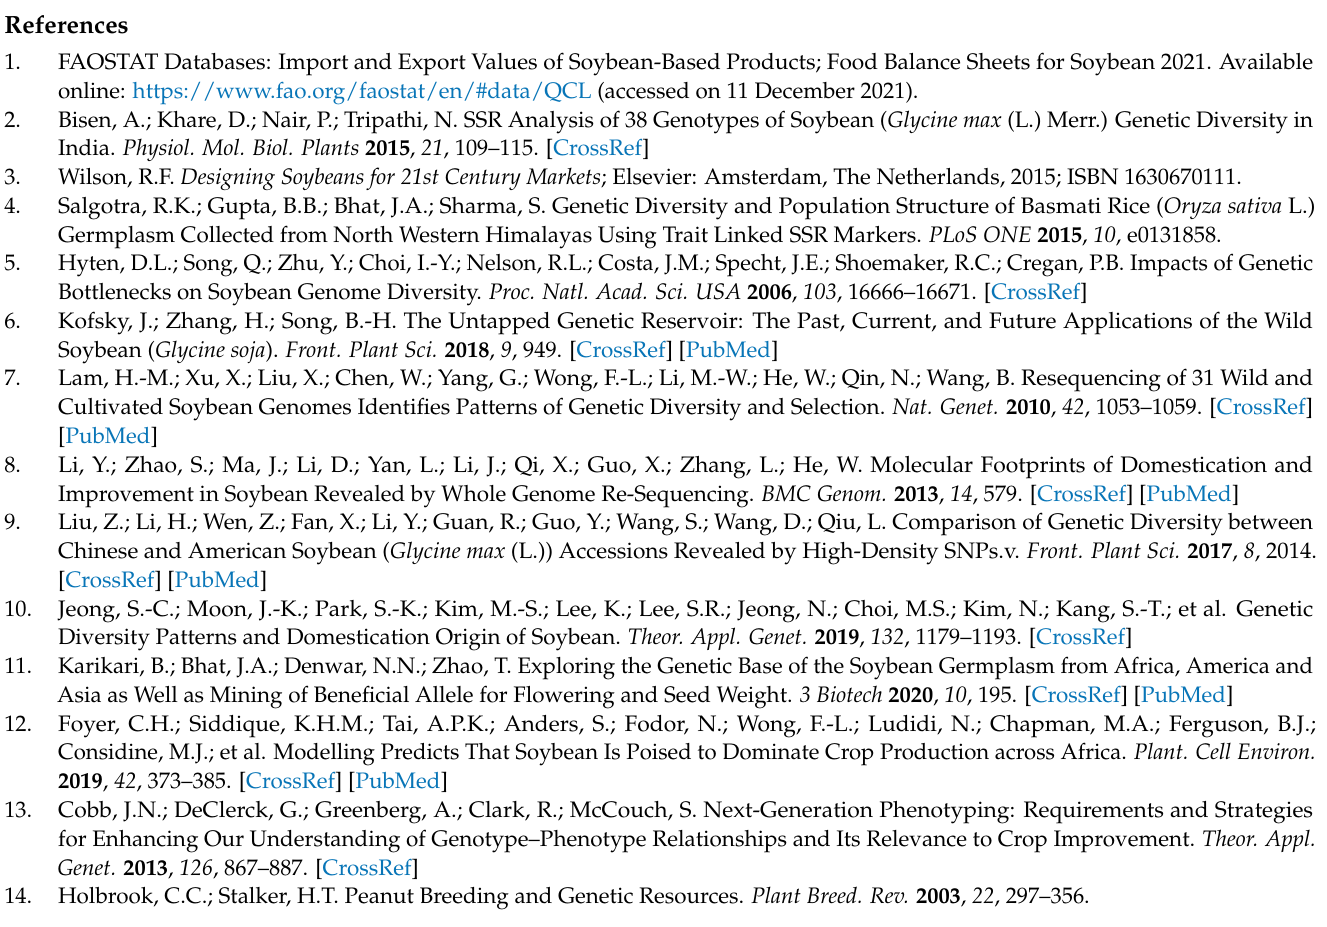
Figure S2: The polymorphic information content of markers. (a) SNP markers and (b) DArT markers; Figure S3: Percentages of molecular variance within and among populations. (a) SNP markers (b) DArT markers; Table S2: Allelic patterns across the populations for SNP and DArT markers; Table S3: List of soybeans and their